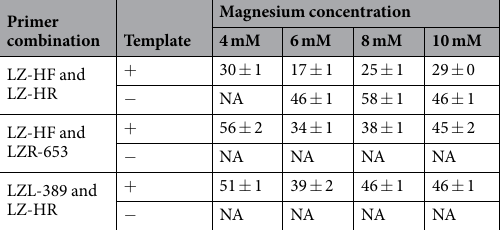
Table 2. Variation of magnesium concentration in the hinge-amplification reaction in combination with three different primers. The test included both hinge-primer and the forward and reverse primer separately.